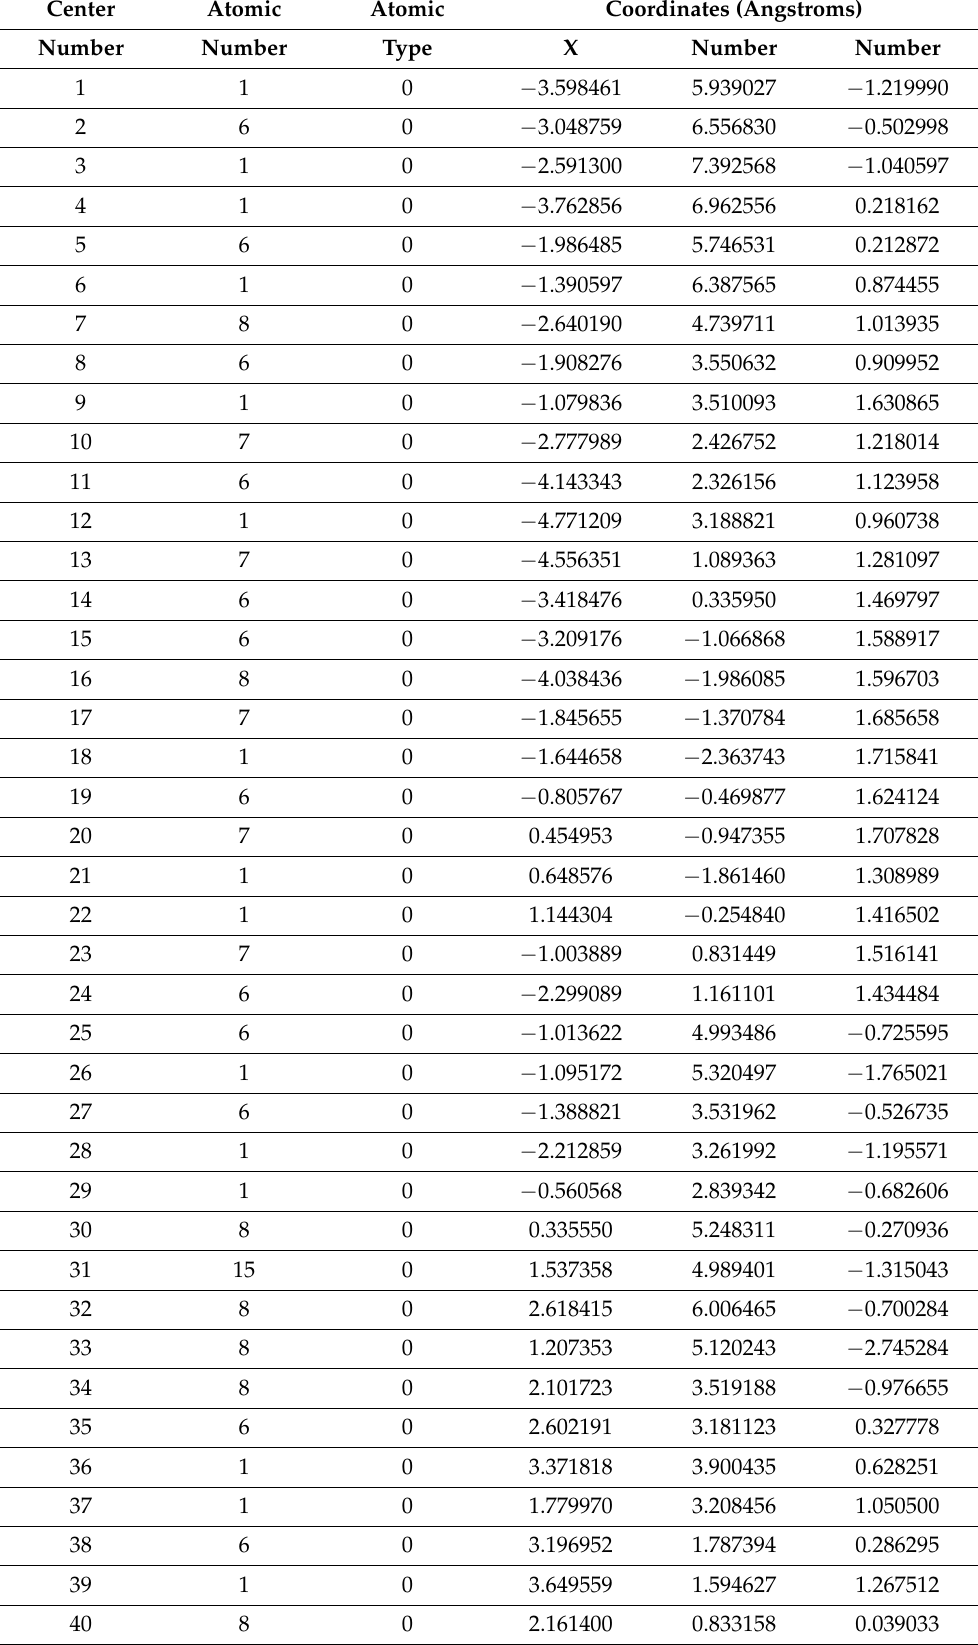
Table A16. Complex LiI 3 with nucleotide triplet